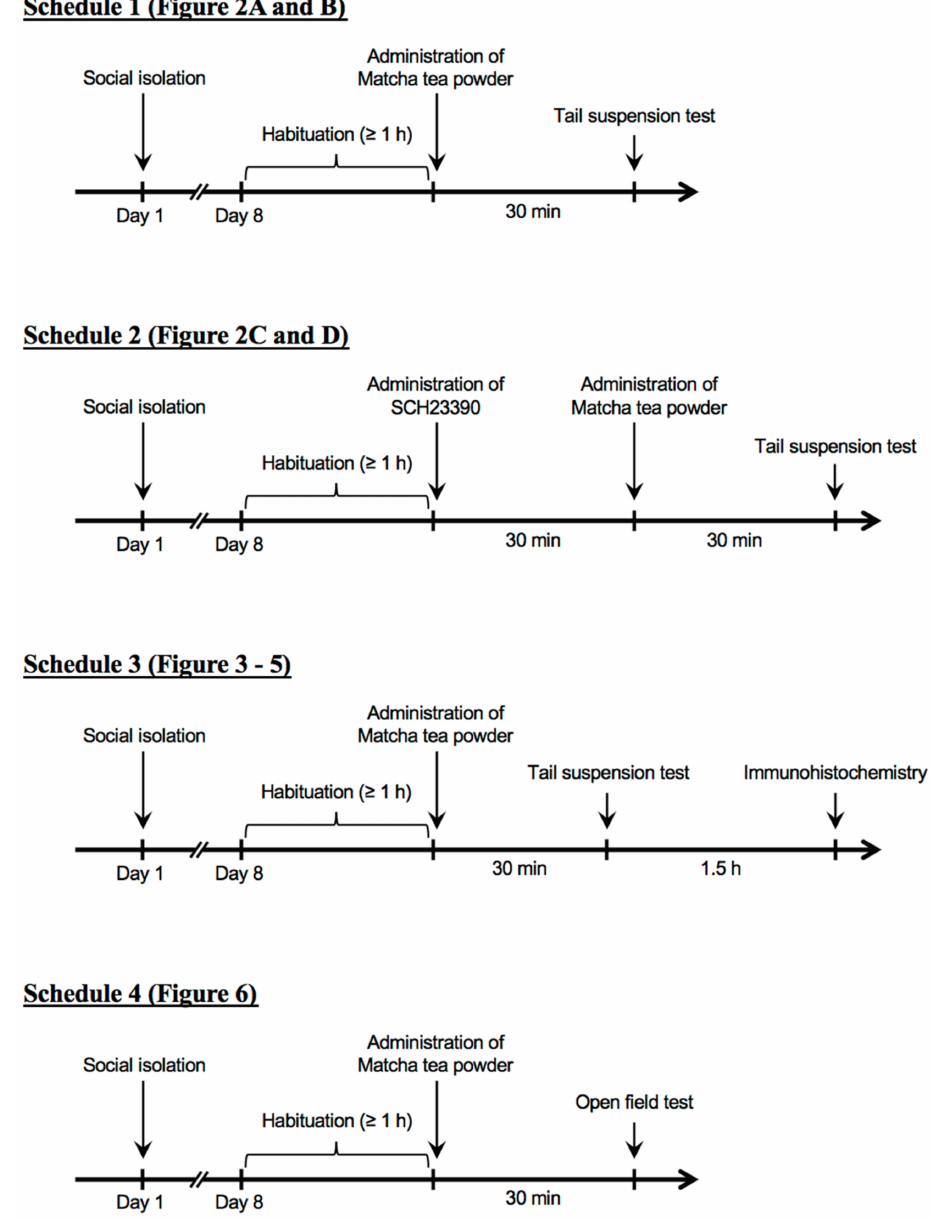
Figure 1. Schematic views of the experimental